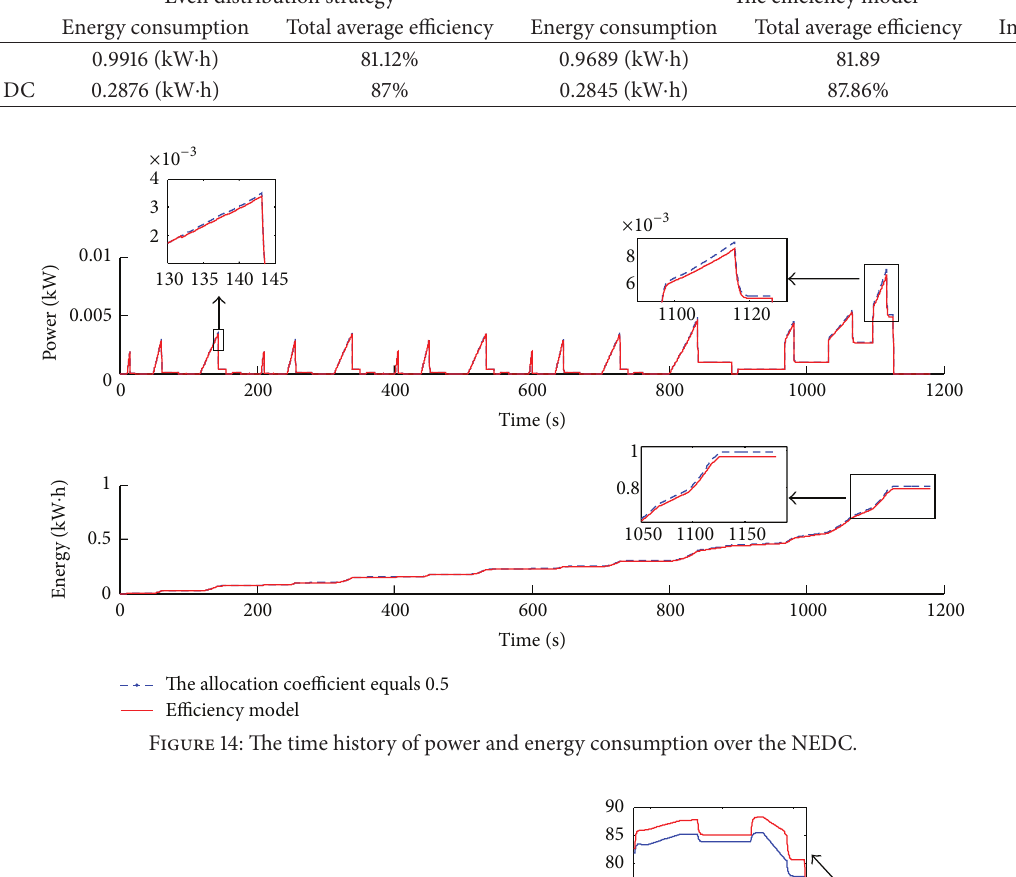
The allocation coefficient equals 0.5 Figure 15: The time history of the total efficiency and acceleration pedal signal over the NEDC.